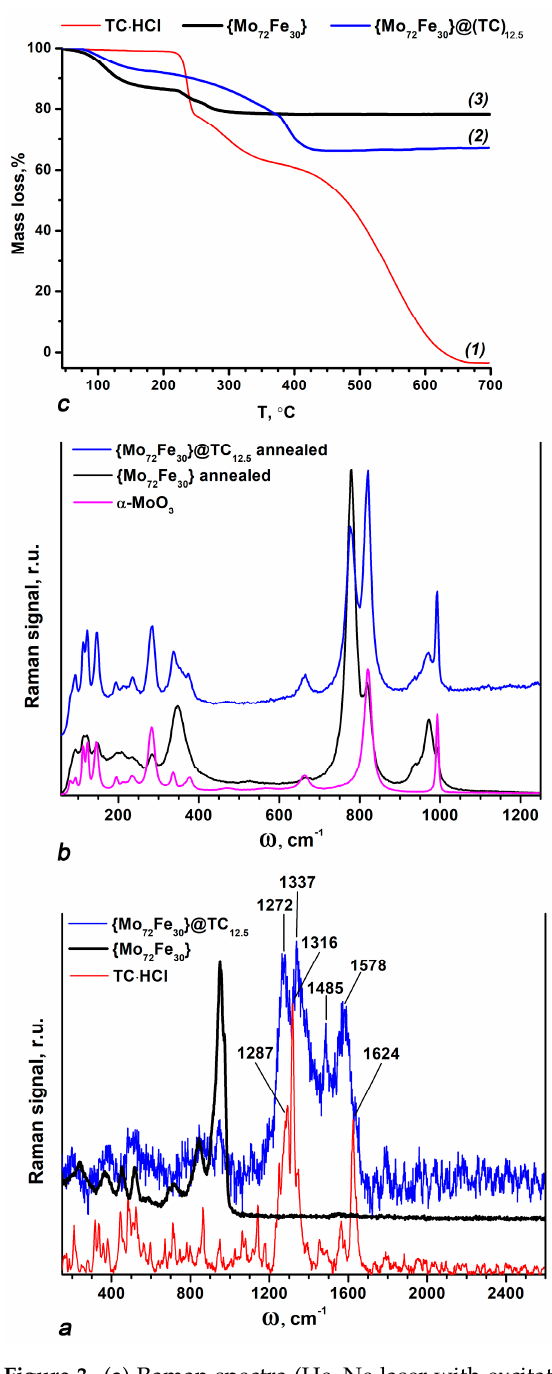
Figure 3. ( a ) Raman spectra (He–Ne laser with excitation wavelength 633 nm) of ТС , {Mo 72 Fe 30 } and {Mo 72 Fe 30 }@ ТС 12.5 (from bottom to top, respectively); ( b ) Raman spectra of α - МоО 3 , {Mo 72 Fe 30 } thermal destruction products and {Mo 72 Fe 30 }@ ТС 12.5 destruction products in situ in the laser beam (from bottom to top, respectively); ( c ) TG curves of ТС , {Mo 72 Fe 30 }@ ТС 12.5 and {Mo 72 Fe 30 } (from bottom to top 1, 2, 3, respectively).